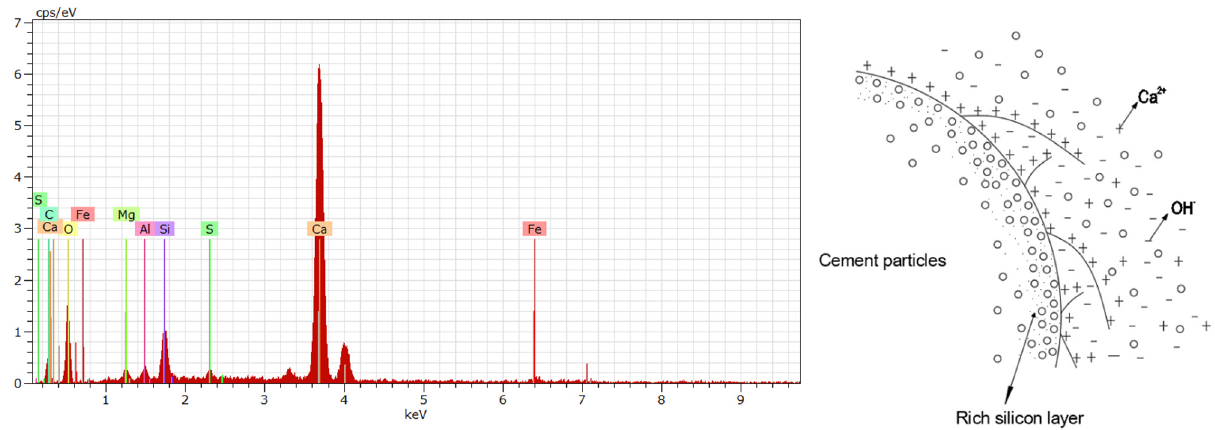
Figure 6. Energy spectrum results of NS-precipitated cementitious materials.